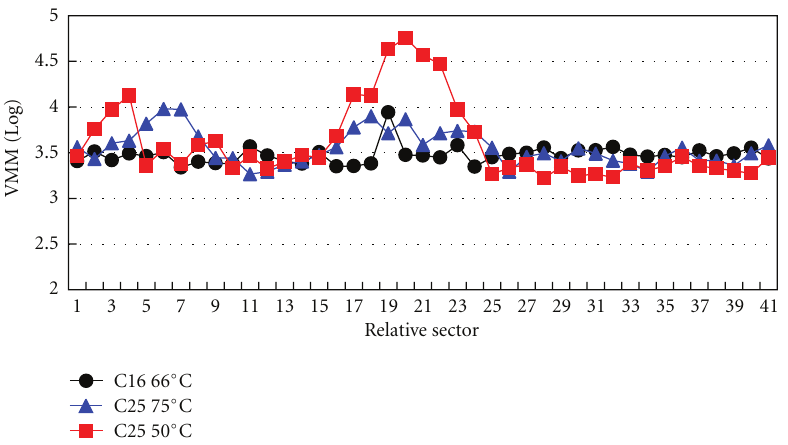
Figure 11: VMM change comparison near the error position (C25 50 ◦ C) or the position where VMM exceeds 3.8 (C16 66 ◦ C, C25 75 ◦ C) in the alkane injection tests.